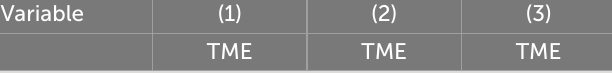
TABLE 4 Regression results of the effect of executive equity incentive on corporate tax avoidance.